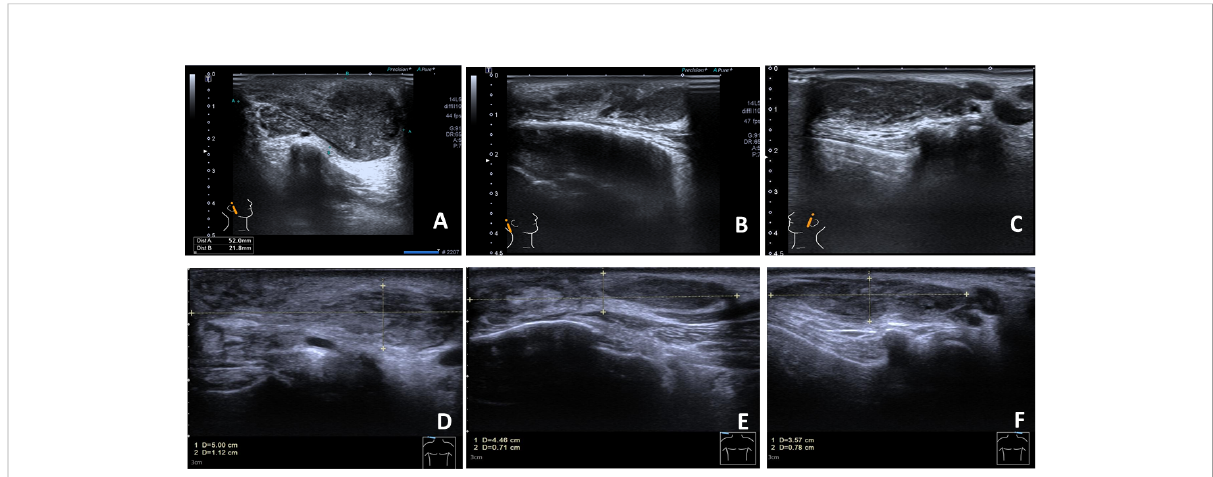
FIGURE 2 The anterior and posterior ears ’ color Doppler ultrasound. The right anterior mass is in the size of 5.2×2.2 cm and has a heterogeneous hypoechoic – isoechoic appearance (right ear in front, right ear behind, and left ear in front); (A – C) before treatment; (D – F) after 16 weeks of treatment with